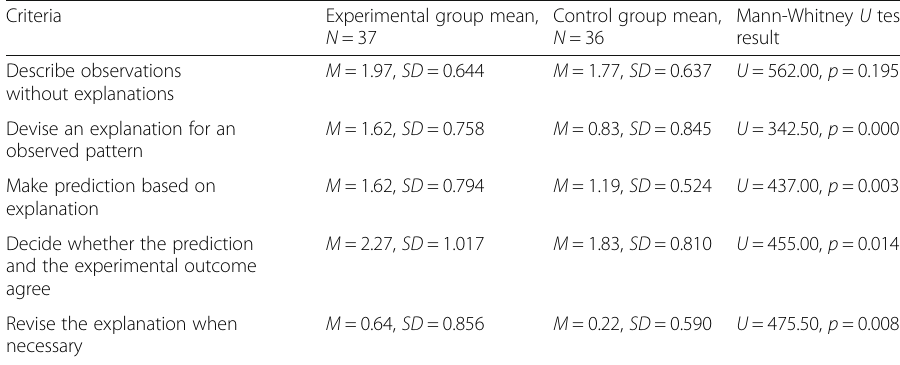
Table 2 Mann-Whitney U test scores Criteria Experimental group mean,